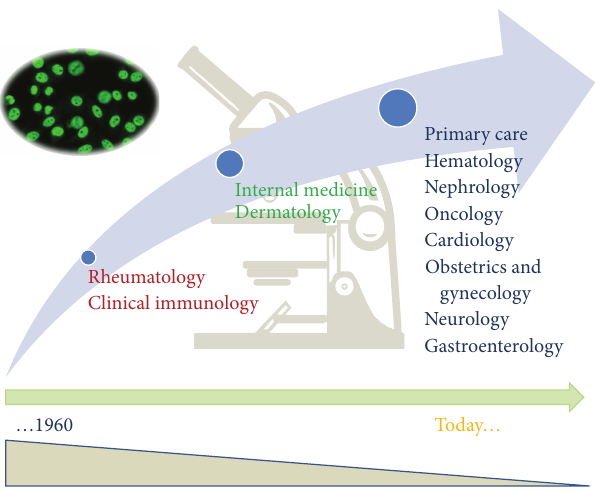
Figure 2: Change in referral patterns. Historically, when the ANA HEp-2 test became available in around 1960 exclusively rheumatologist and clinical immunologists ordered the ANA test. With the emerging recognition that many other diseases are associated with ANAs, a broad range of clinical disciplines order the ANA test. With changes in the ANA referral pattern and the associated decrease in the pretest probability, the posttest probability significantly decreases (indicated by the triangle).